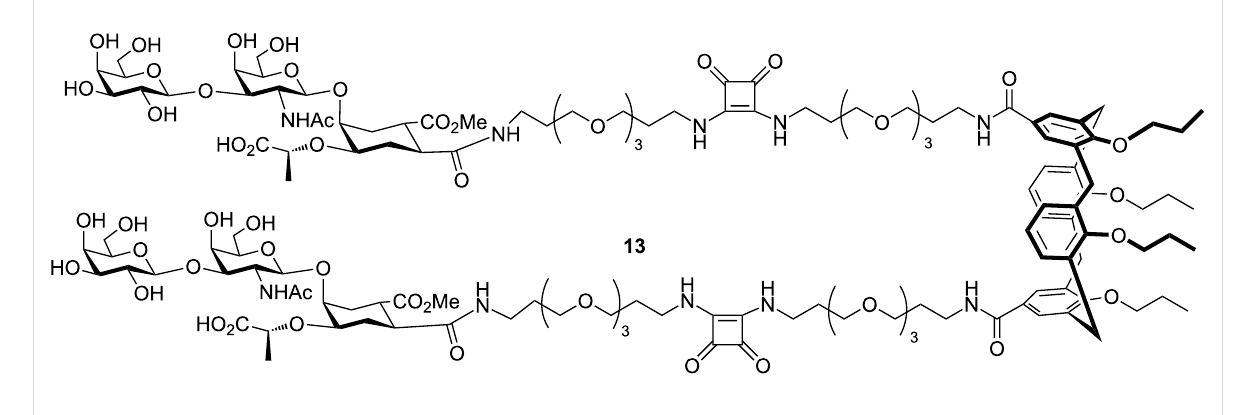
Figure 6: Bivalent inhibitor designed and synthesized by Arosio et al.